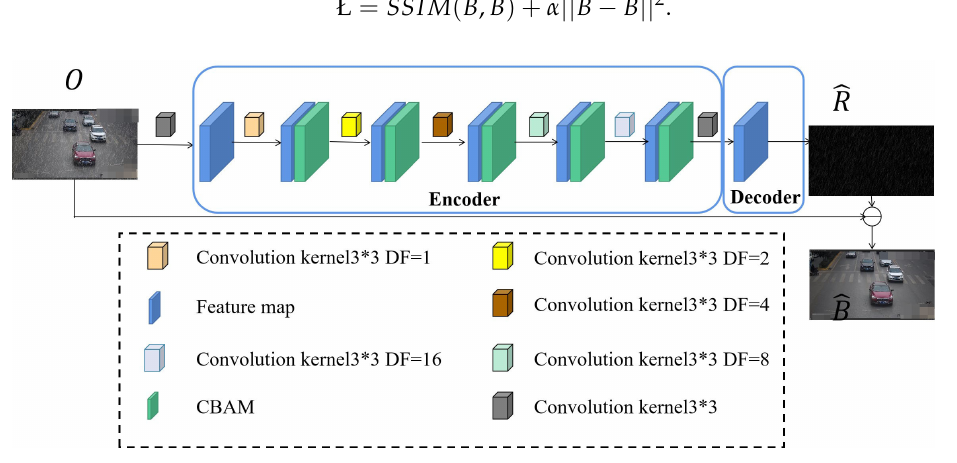
Figure 15. Illustration of LDVS